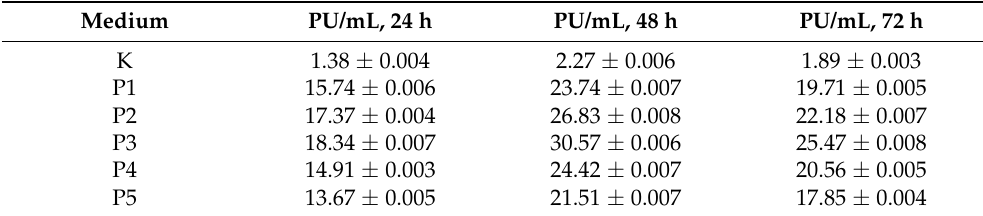
Table 4. Proteolytic activity of Bacillus subtilis in medium supplemented with native bovine collagen protein and